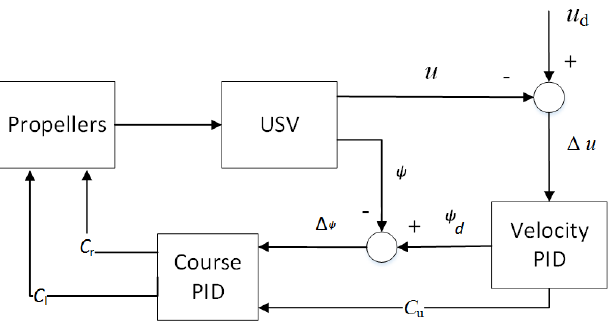
Figure 10. The speed and course PID controllers.